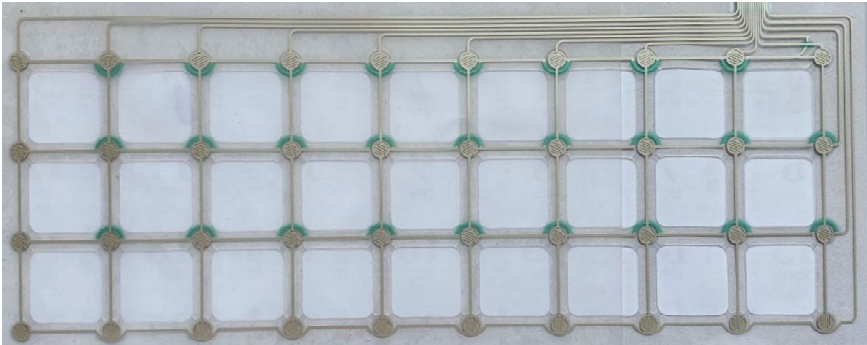
Figure 5. Picture of the force-pad from RoxiFSR Inc., Changzhou, China (http://www.rox- ifsr.com/productinfo/1018397.html).